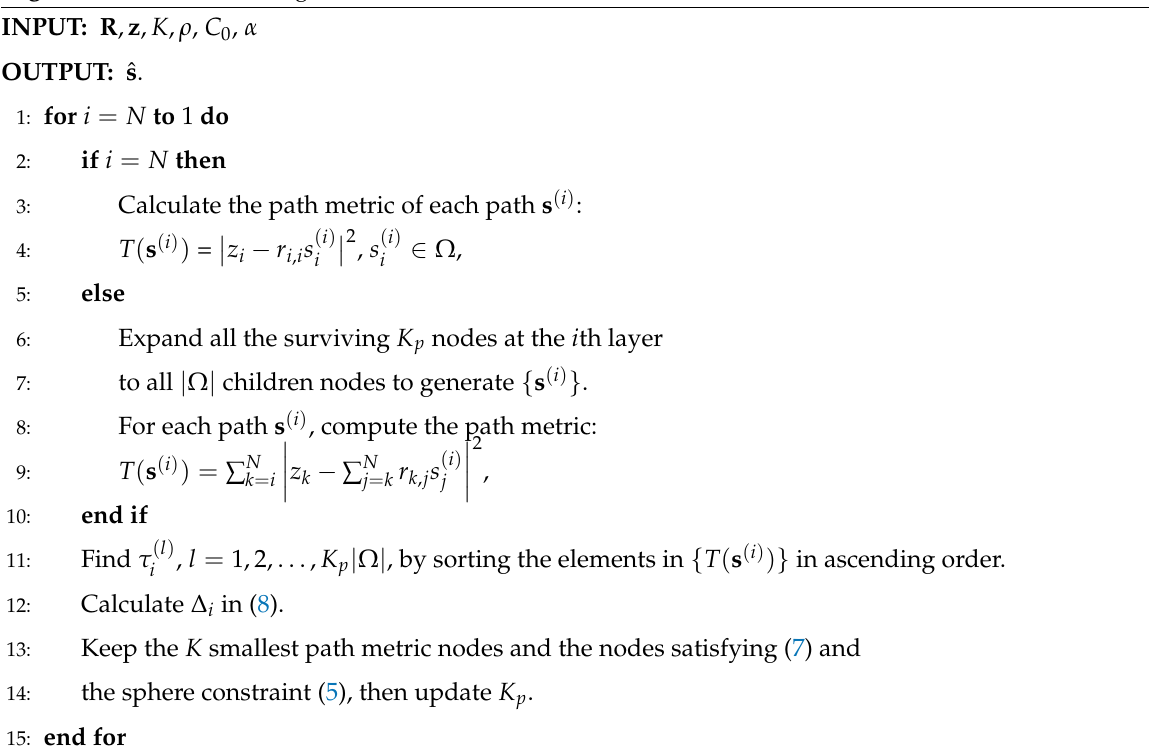
Algorithm 1 The AKSD